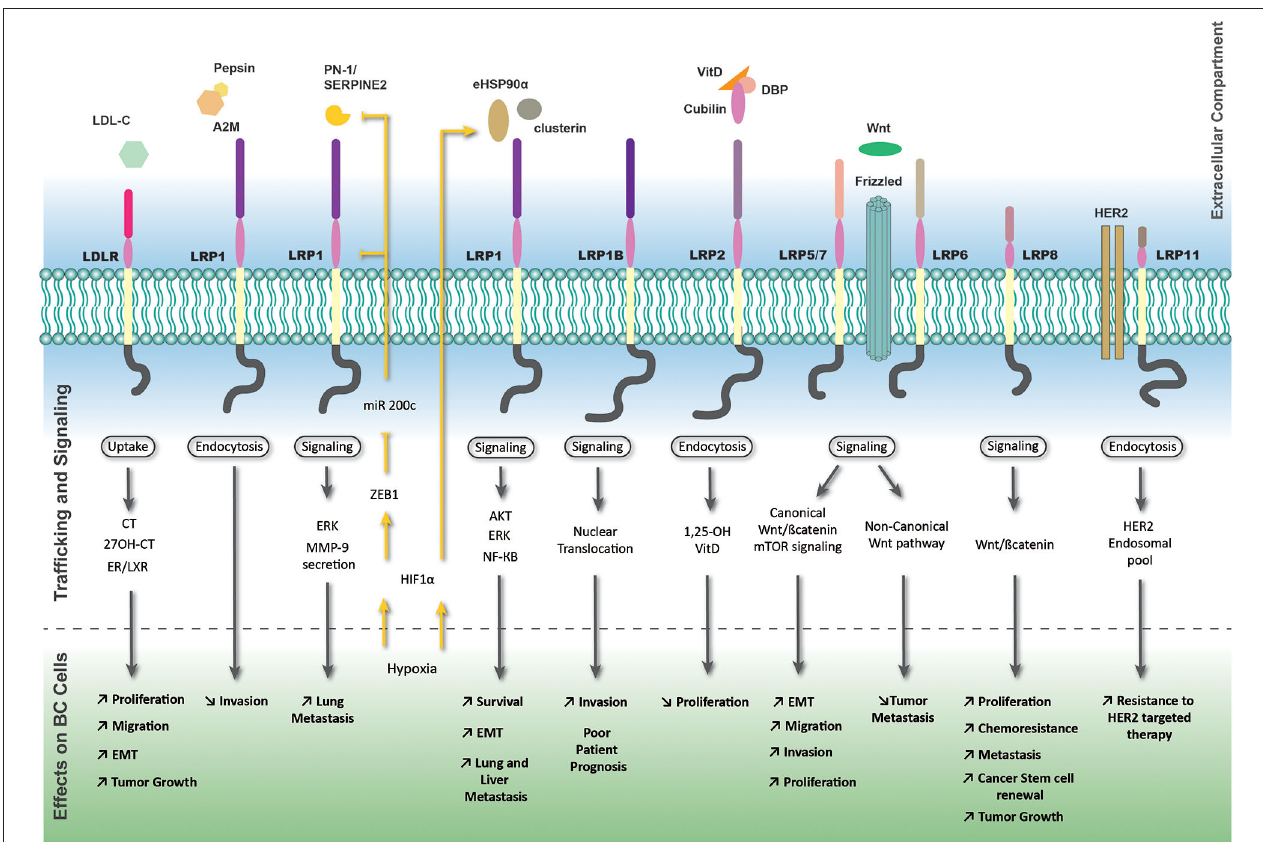
FIGURE 1 | LRP-mediated signaling pathways and trafficking in breast tumor cells. The most important members of the LDLR family exhibiting effects on breast cancer cells are represented with their associated extracellular ligands. Outside-in and inside-out pathways are represented by black and yellow arrows or lines, respectively. The yellow strikethrough line indicates an inhibition. A2M, alpha-2 macroglobulin; CT, cholesterol; ER, estrogen receptor; LXR, liver X receptor; VitD, vitamin D.